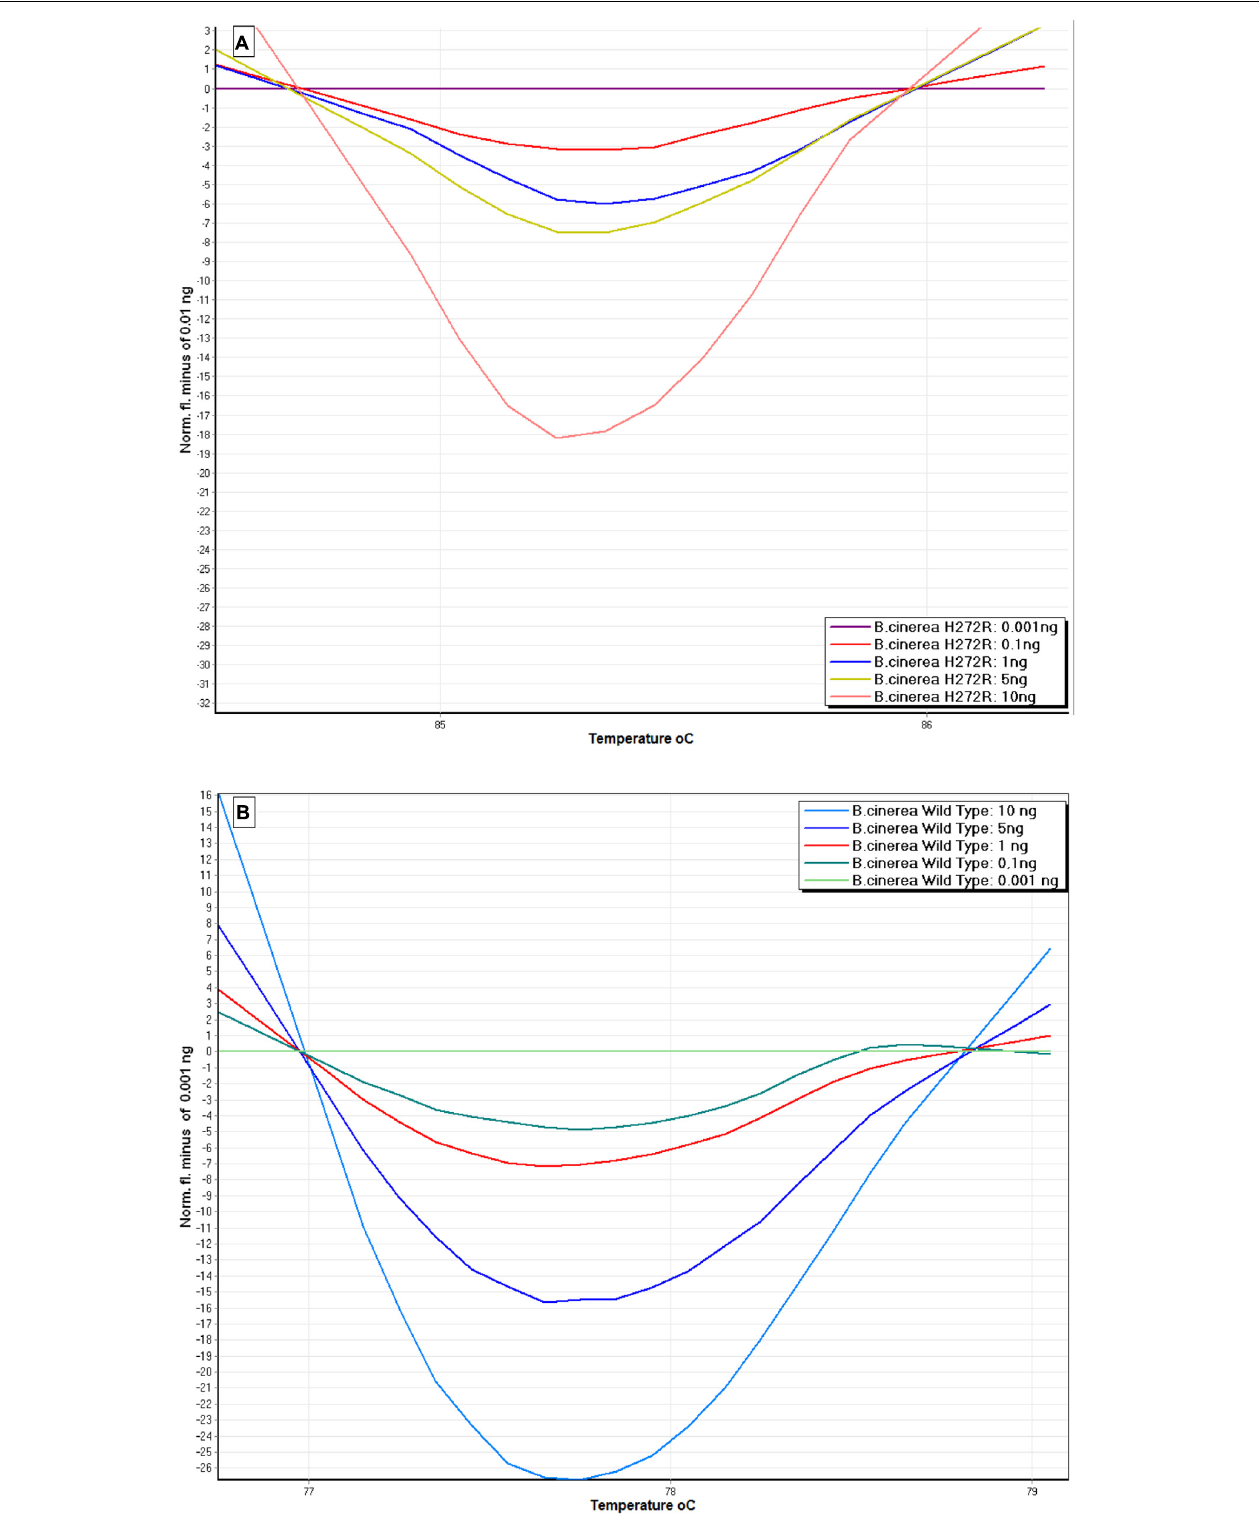
FIGURE 4 | Sensitivity of HRM assay to detect DNA of a B. cinerea isolate possessing the H272R mutation (A) and a wild-type isolate (B) . Difference curves were generated using 0.1–10 ng DNA per reaction tube. 0.001 ng of genomic DNA from B. cinerea was used as reference baseline curve.